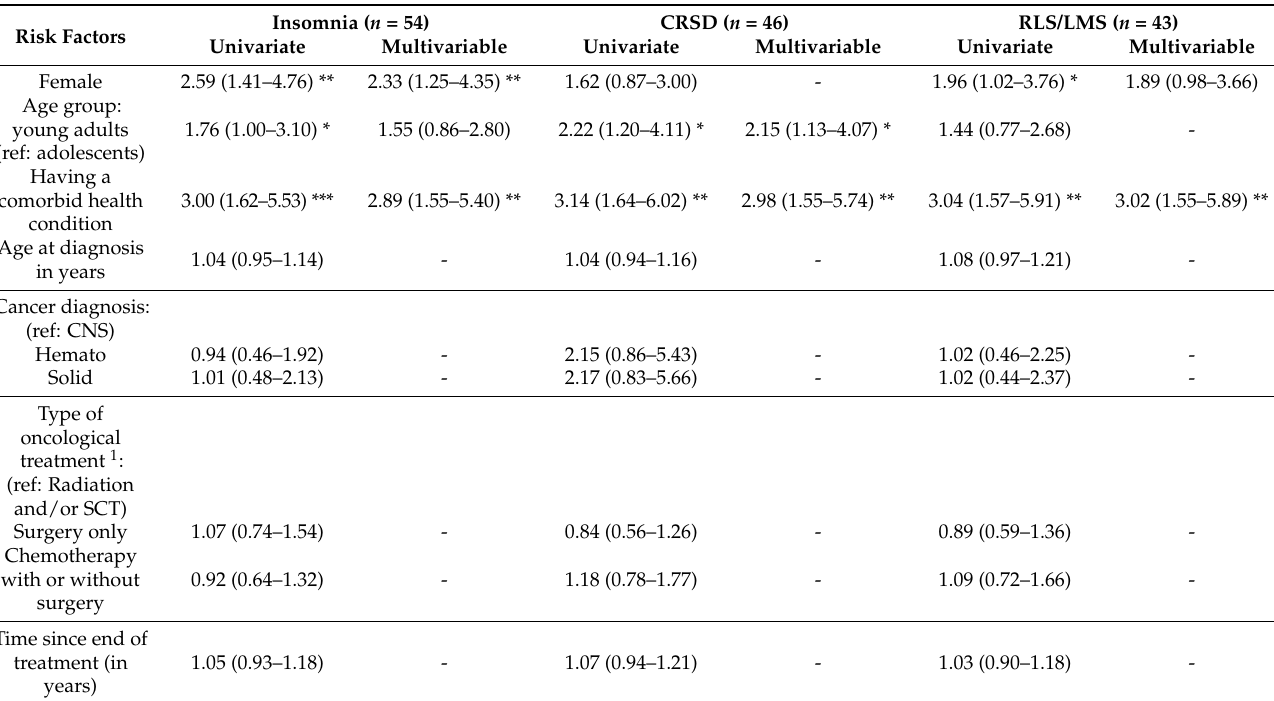
Table 3. Risk factors for sleep disorders according to the HSDQ (OR and 95% confidence